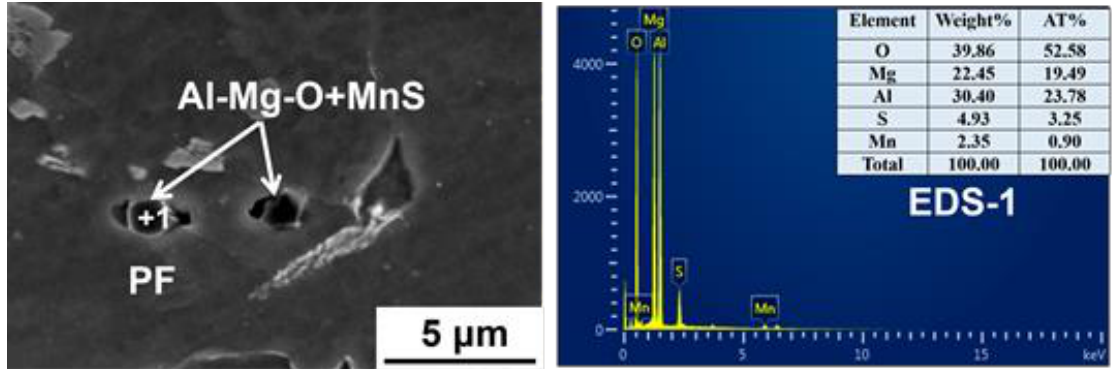
Figure 15. The relationship between Al – Mg – O+MnS inclusion and ferrite in the FGHAZ of No.2 steel.